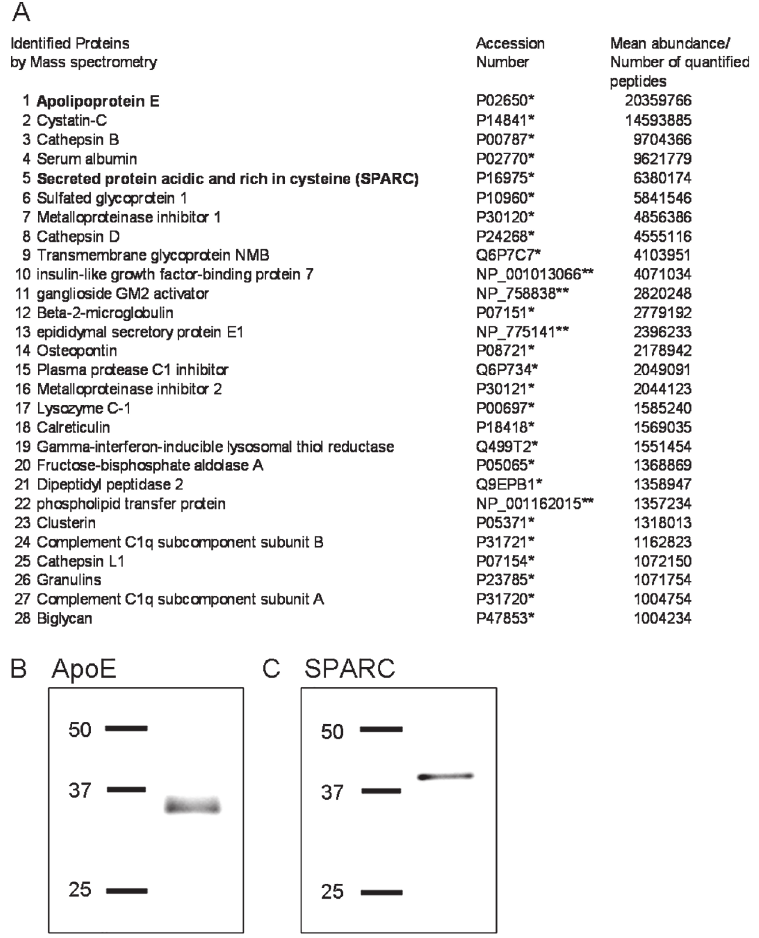
Fig 3. Mass spectrometric analysis of retinal glial conditioned medium shows that ApoE and SPARC are present in high abundance. (A) Mass spectrometric analysis of retina glial conditioned medium listing proteins ( * Swiss/Prot Identifier, ** RefSeq peptide Identifier) at mean abundance levels (n = 3 separate samples)/number of quantified peptides above 1000000. Western blots confirming the presence of (B) ApoE and (C) SPARC in retinal glial conditioned medium. Molecular weight markers in